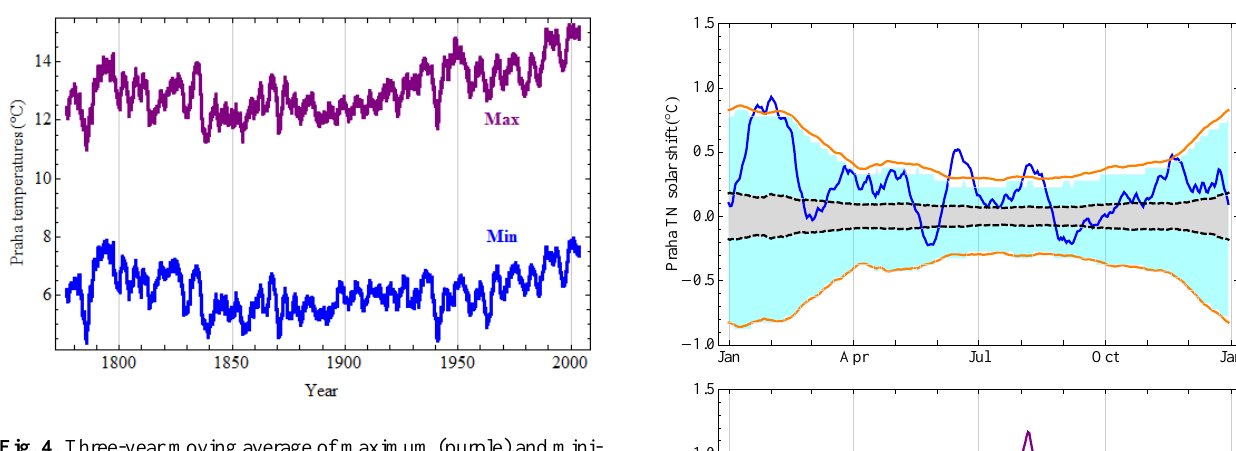
Fig. 4. Three-year moving average of maximum (purple) and mini- mum (blue) temperatures for Praha.